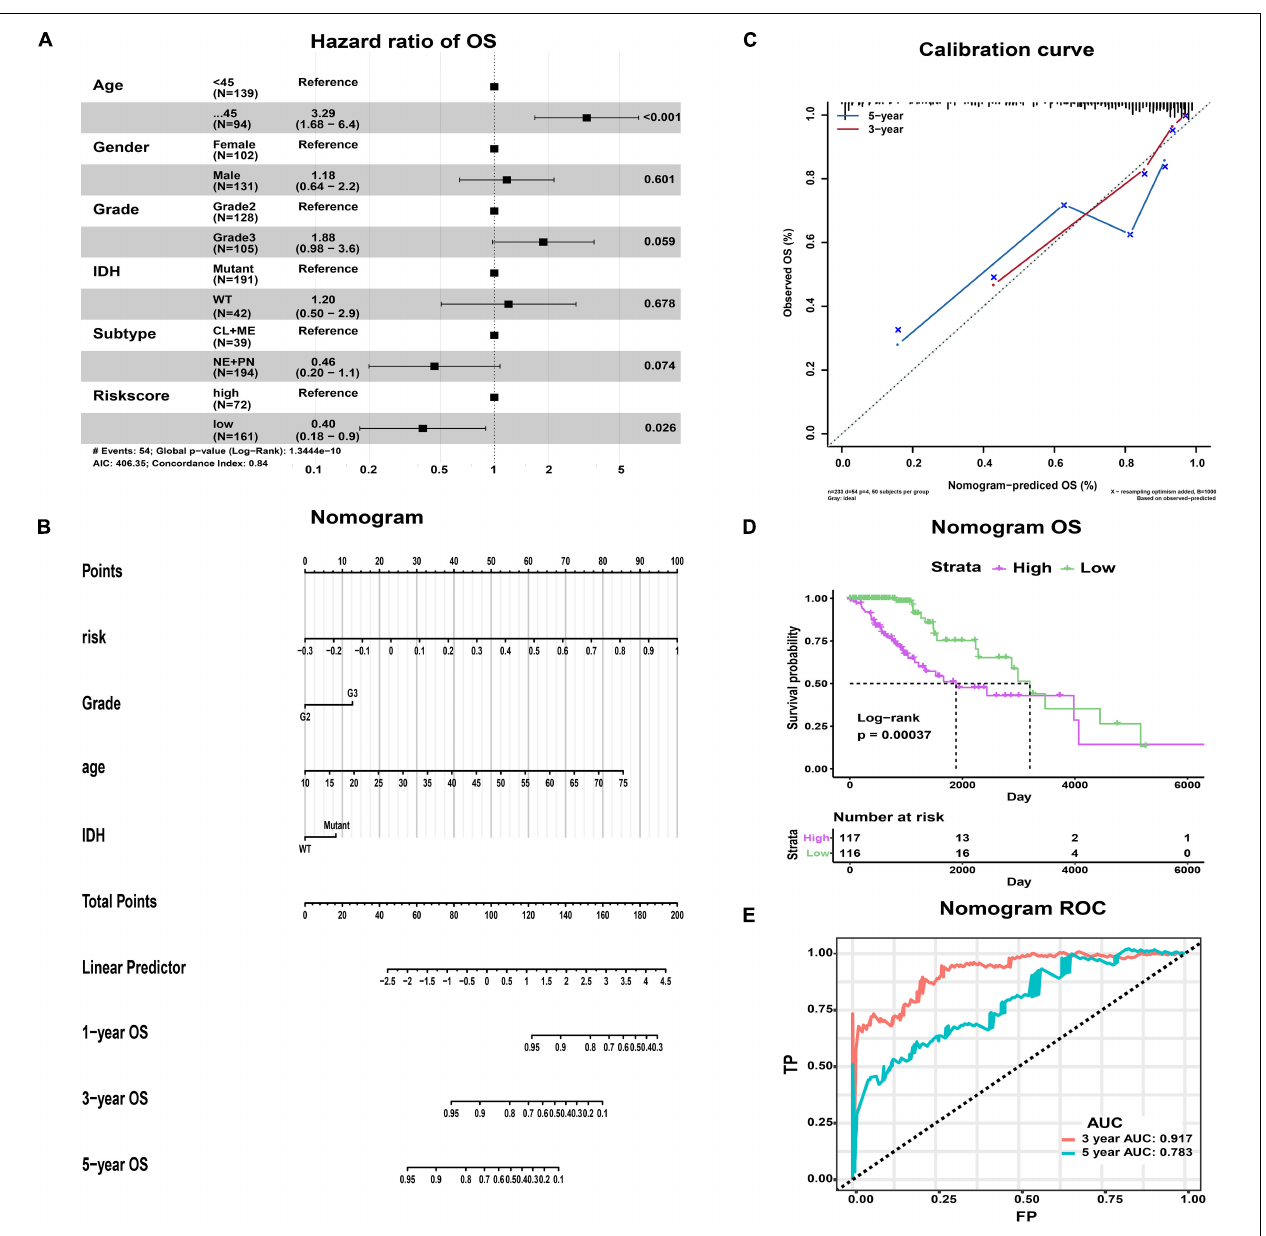
FIGURE 6 | The nomogram predicting the OS of LGG patients with epilepsy. (A) Forest map showing the results of multivariate Cox regression analysis. (B) The nomogram was used by summing the points of each variable. (C) The calibration curves showing the predicted and actual observed OS rates. (D) K-M plot showing the difference in OS between high- and low-risk groups. (E) The ROC curves and AUC values of the